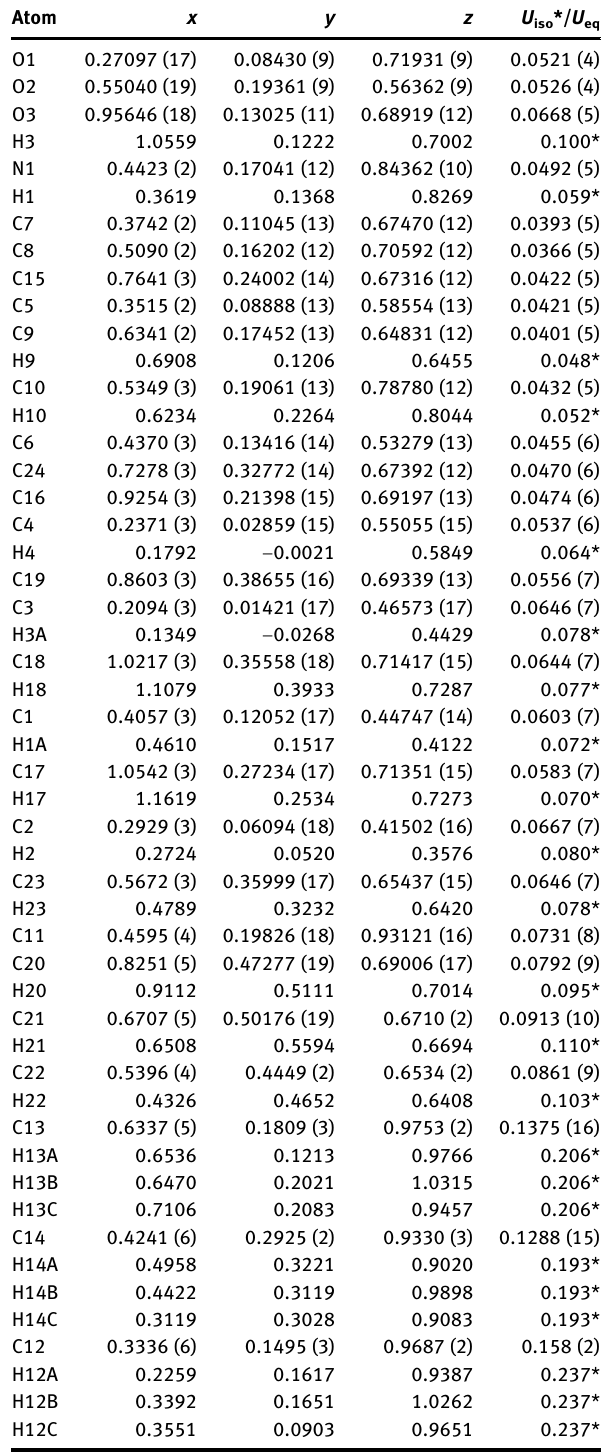
Table  : Fractional atomic coordinates and isotropic or equivalent isotropic displacement parameters (Å 